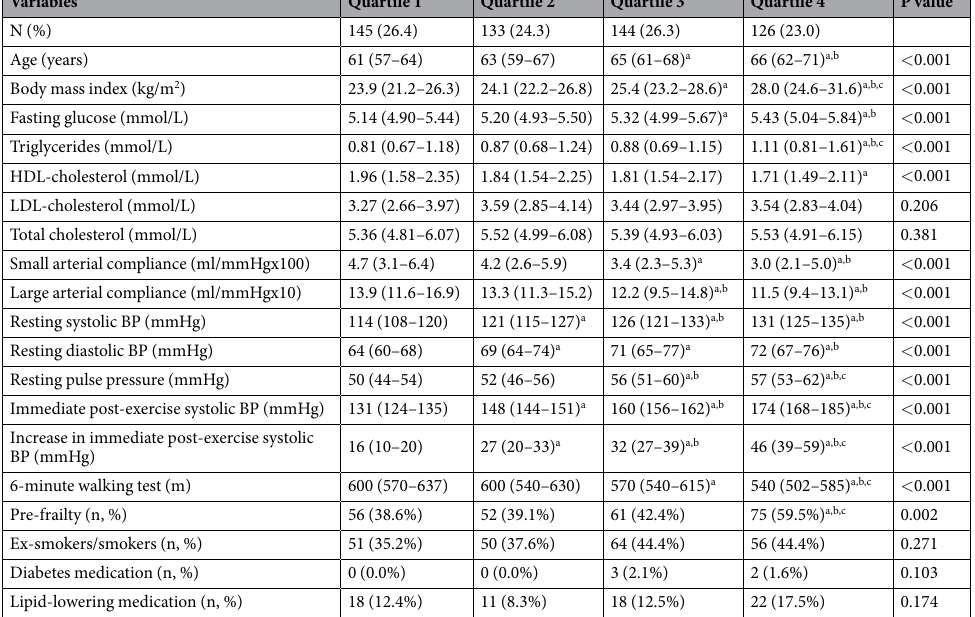
Table 2. Characteristics of the participants according to quartiles of immediate post-exercise systolic blood pressure (n = 548). Abbreviations: BP, blood pressure; Quartile 1: immediate post-exercise systolic BP ≤ 140 mmHg; Quartile 2: immediate post-exercise systolic BP 141–153 mmHg; Quartile 3 immediate post- exercise systolic BP 154–164; Quartile 4: immediate post-exercise systolic BP ≥ 165 mmHg. Data are expressed as median and percentiles 25–75 or absolute (n) and relative (%) frequencies. a Different from quartile 1 (p < 0.05); b Different from quartile 2 (p < 0.05); c Different from quartile 3 (p <